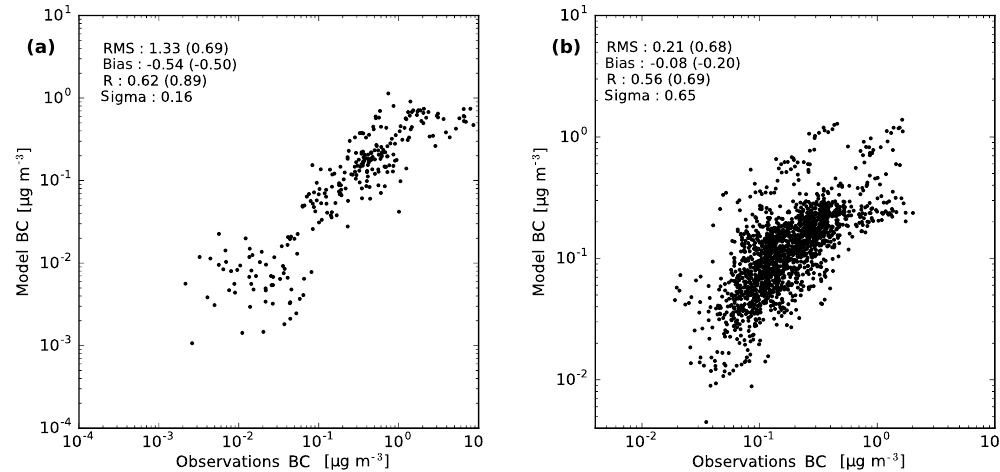
Figure 8. Scatter plots of yearly mean aerosol mass concentrations observed at EMEP (a) and IMPROVE (b) stations versus those from SALSA2.0 simulations for BC for years 2003–2012. The given statistical values are the same as in Fig. 6.